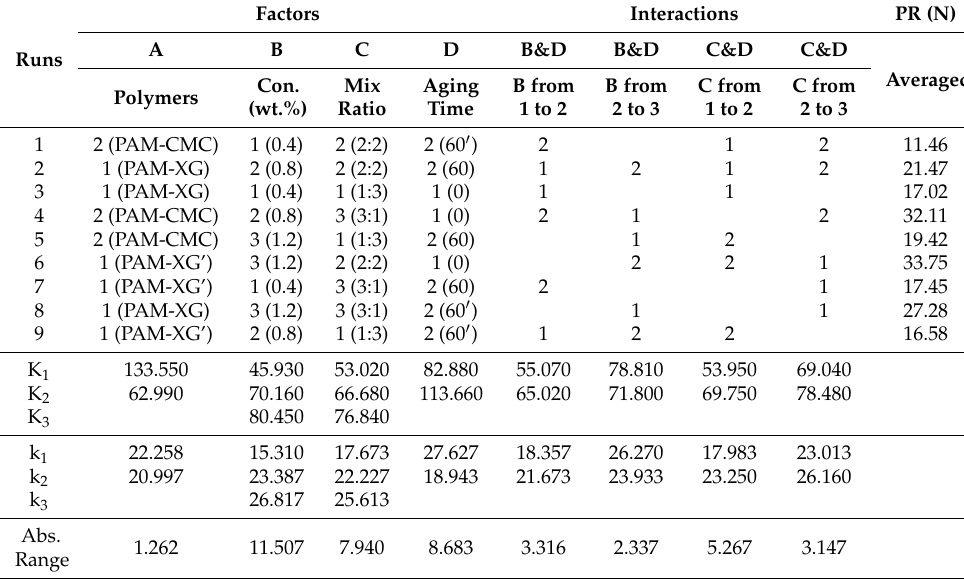
Table 4. Orthogonal data analysis of self-aging test for individual polymer application.